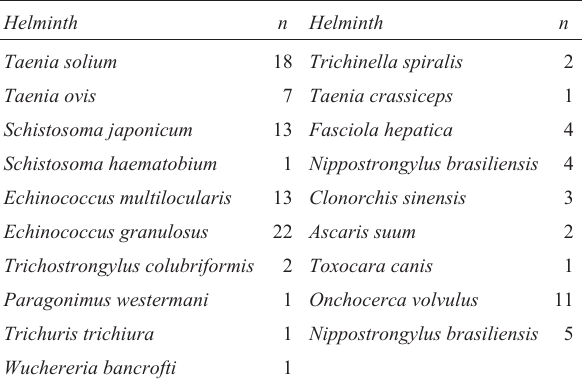
Figure 3 - Amino acid distribution throughout the